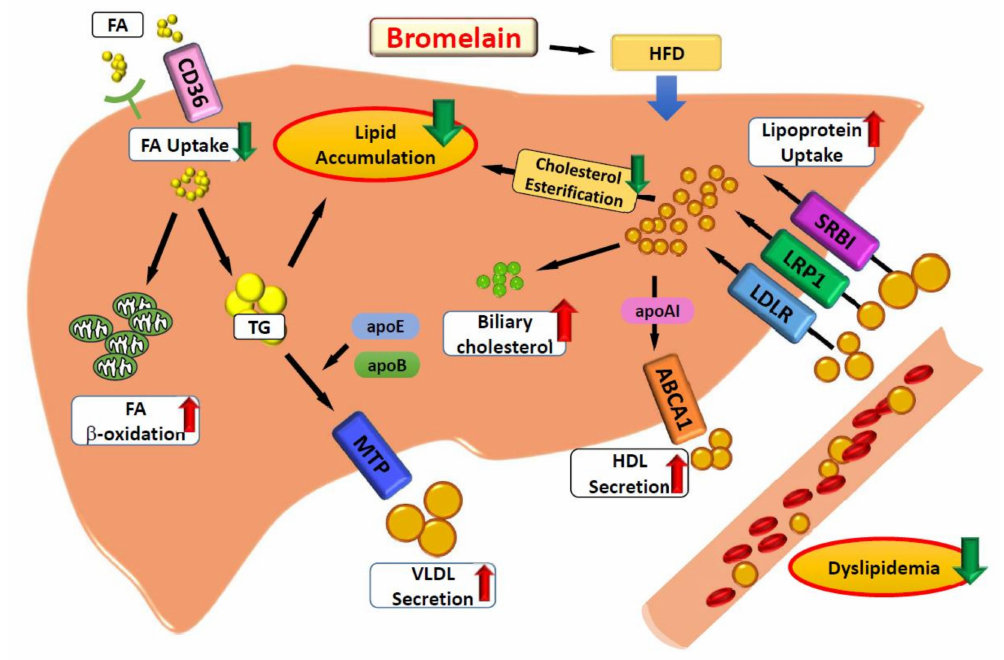
Figure 7. Bromelain has a beneficial e ff ect on the deregulation of lipid metabolism by high-fat diet (HFD) in the liver by modulating multiple metabolic pathways. Bromelain prevents HFD-induced hyperlipidemia and hepatic lipid accumulation by decreasing fatty acid uptake and cholesteryl ester synthesis and promoting lipoprotein internalization, bile acid metabolism, cholesterol clearance, very-low density lipoprotein (VLDL) assembly and secretion, and the β -oxidation of fatty acids. These key events might work in concert to decrease the HFD-induced lipid accumulation in the liver. Supplementary Materials: The following are available online at http: // www.mdpi.com / 2072-6643 / 12 / 5 / 1458 / s1. Figure S1: E ff ect of bromelain on adipose tissues, Figure S2. E ff ects of bromelain on body weight, tissue weight, and blood lipids of chow diet-fed